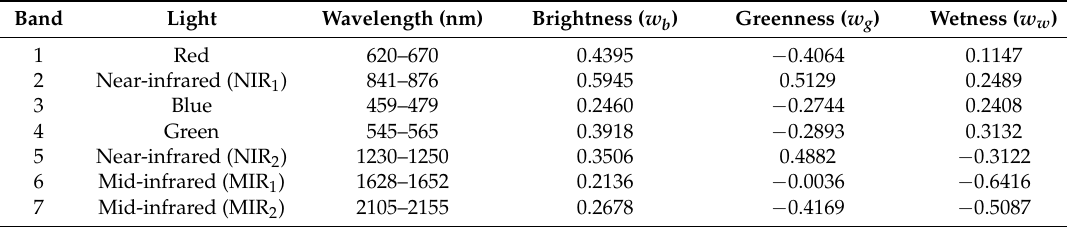
Table 1. MODIS instrument specifications and tasseled cap coefficients from